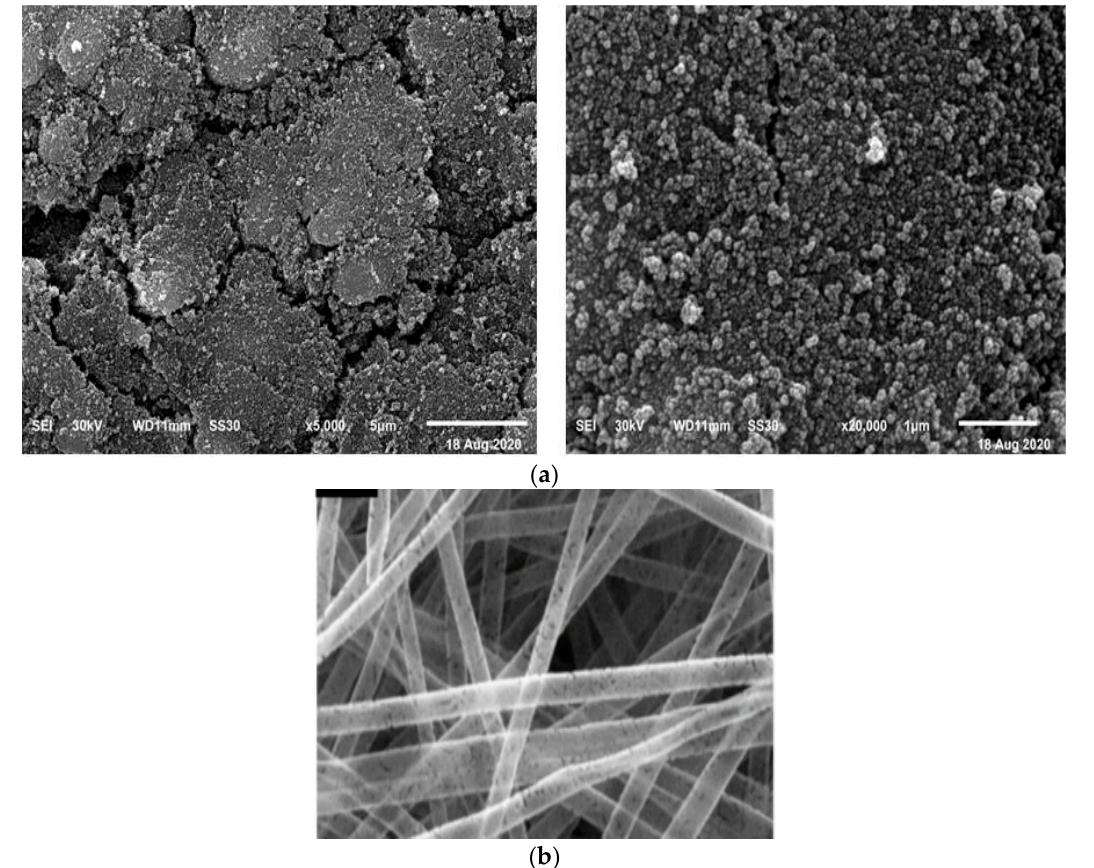
Figure 4. ( a , b ) Scanning Electron microscope (SEM) of titanium nanostructures TiO 2 -NPs and TiO 2 -nanotubes.